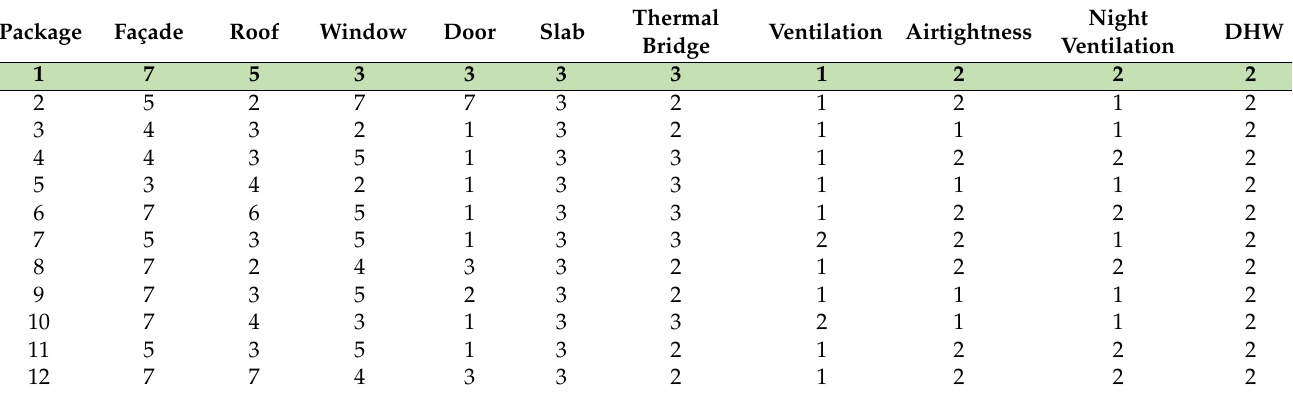
Table 5. Packages of Optimal Solutions